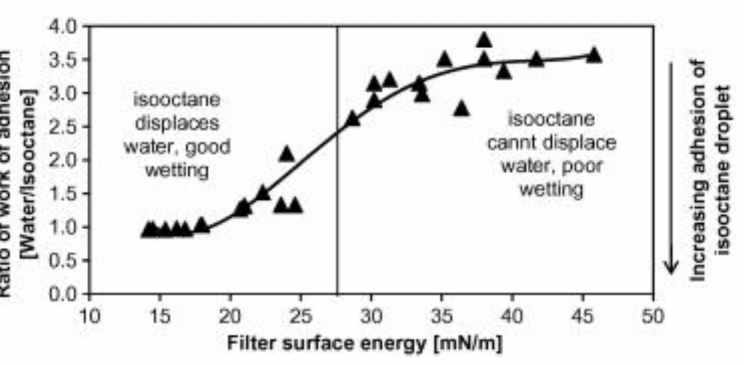
Figure 8. Influence of the solid surface energy on the work of adhesion and wetting of iso-octane and